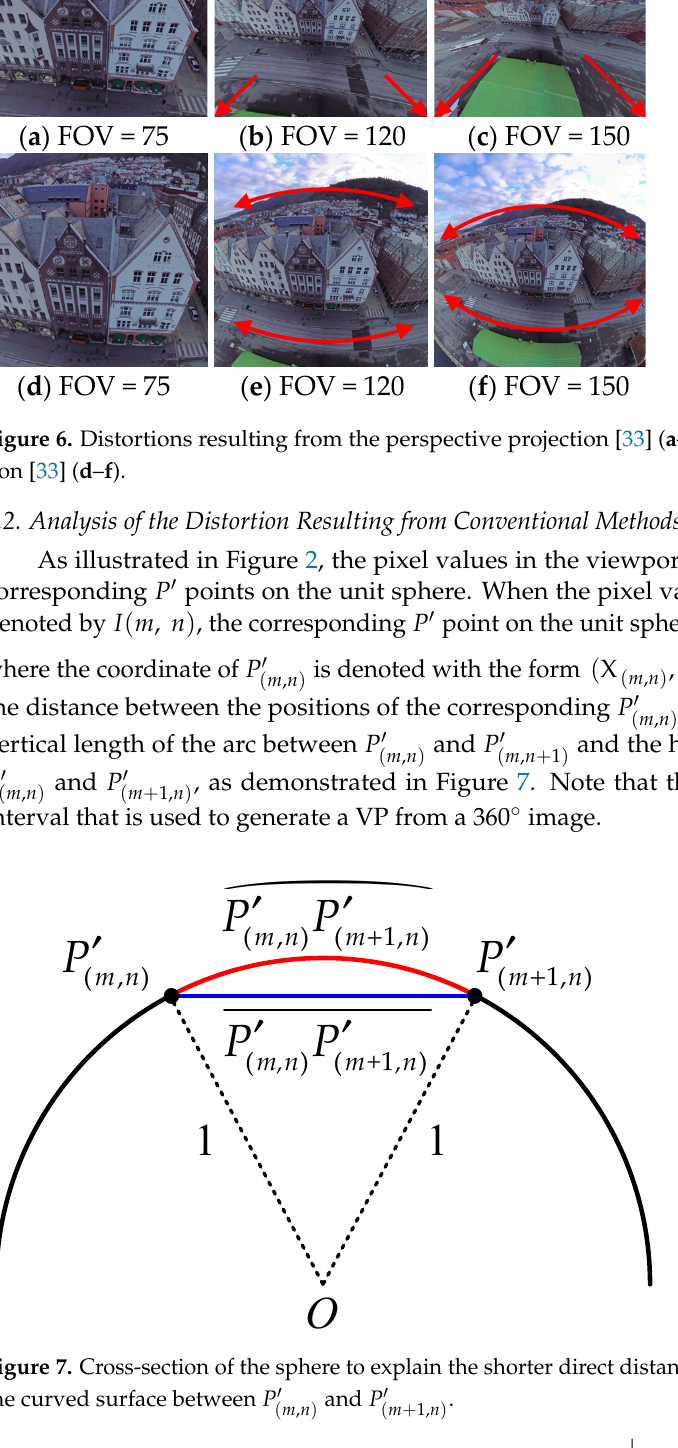
and P (cid:48) . ʹ and P ʹ . ( m , n ) ( m + 1, n ) ( m,n ) ( m+1,n ) (cid:12) (cid:12) { (cid:12) (cid:12) (cid:12) (cid:12) (cid:48) (cid:12) (cid:12) (cid:12) (cid:12) h ( m , n ) = P (cid:48) P (cid:48) P (cid:48) are the shortest (cid:12) P (cid:12) and l (cid:12) (cid:12) ʹ P ʹ (cid:4698) and l h ( m, n )= (cid:4698) P ʹ P ʹ (cid:4585)(cid:4589)(cid:4589)(cid:4589)(cid:4589)(cid:4589)(cid:4589)(cid:4587) (cid:4698) are the shortest di- ( m , n ) ( m + 1, n ) ( m , n ) ( m + 1, n ) (cid:12) (cid:12) ( m,n ) ( m+ 1 ,n ) ( m,n ) ( m+ 1 ,n ) ʹ neighbors. neigh- ( m , n ) ( m,n )